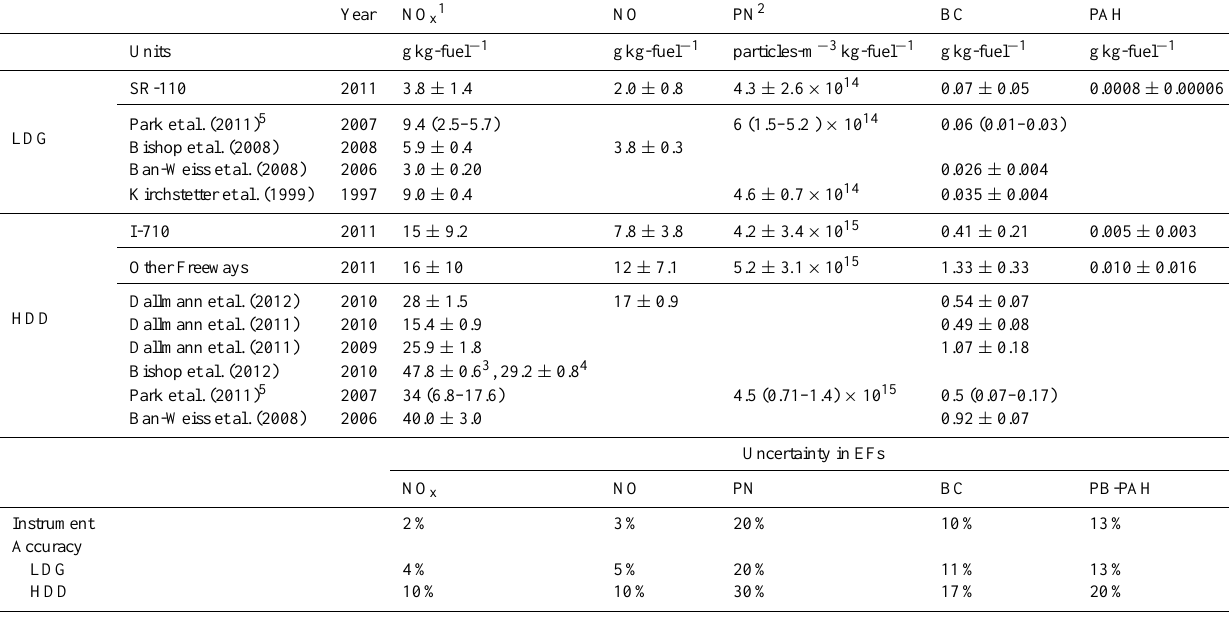
Table 1. Emission Factors for LDV and HDV fleet. Values have been reported as average ± standard